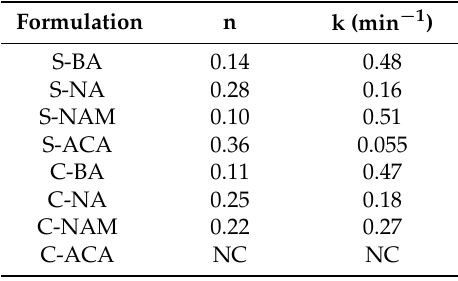
Table 2. Values extracted from Kormeyer-Peppas analysis of the AI release data at pH 1. Formulation n k (min − 1 ) S-BA